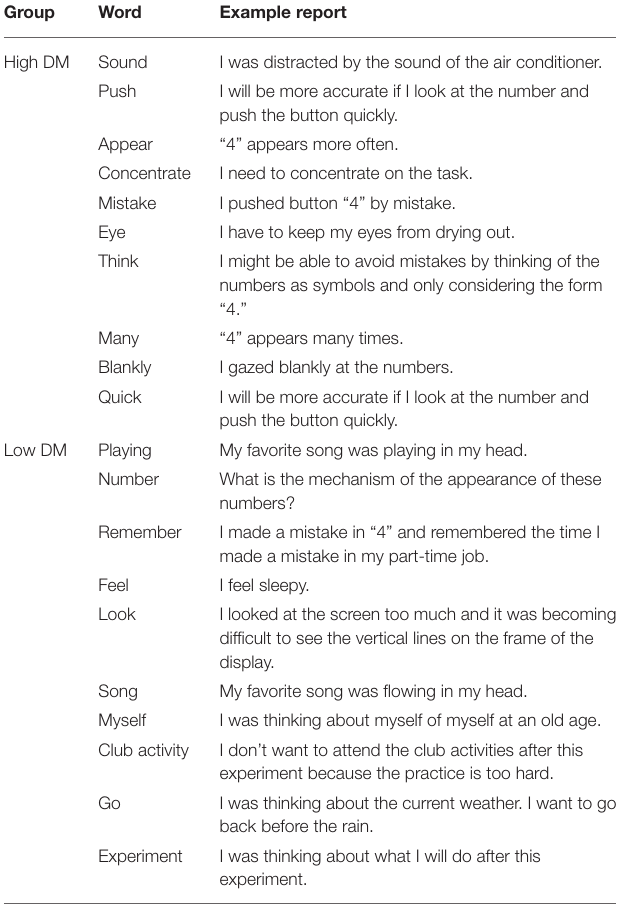
TABLE 3 | Example of the reports for each word in the co-occurrence network analysis for decision-making